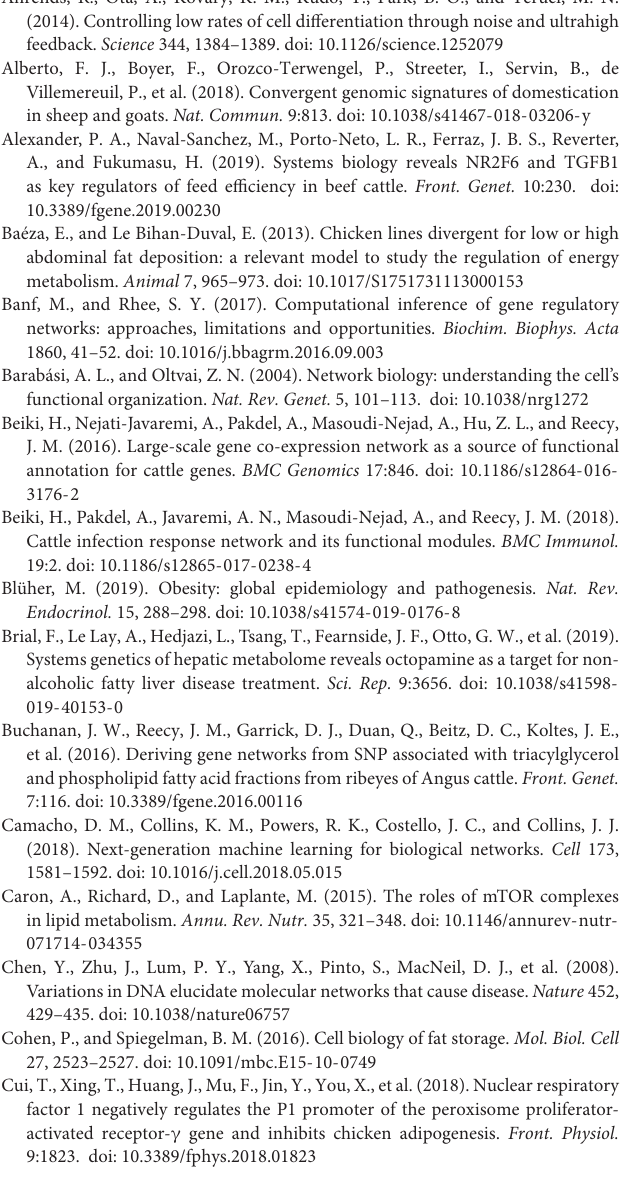
adipose tissue RNA-seq dataset (C) and one sample outlier was discarded for the adipose tissue microarray (D) .